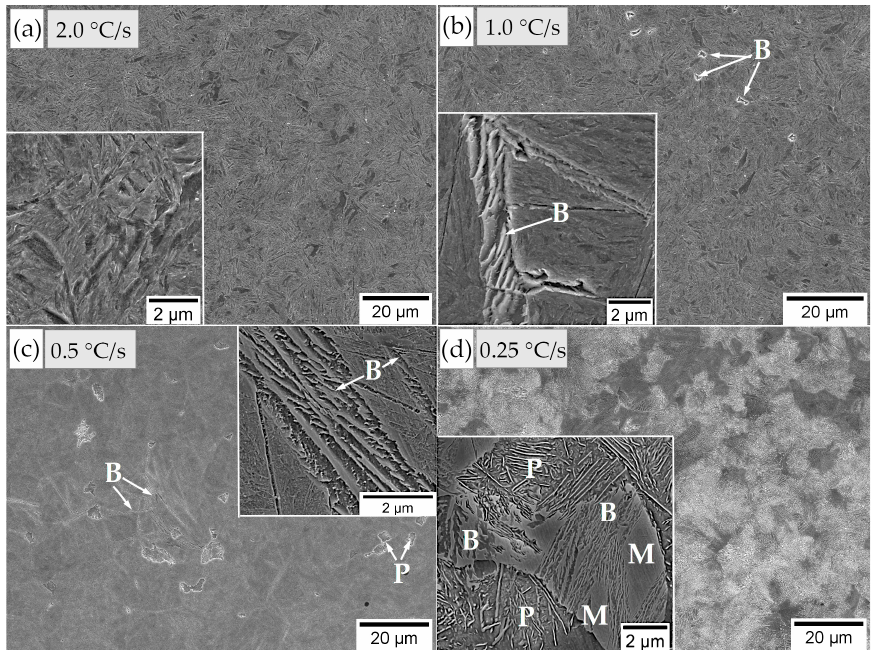
Figure 7. Microstructures of experimental steel after selected continuous cooling cycles. ( a ) 2.0 ◦ C/s; martensite. ( b ) 1.0 ◦ C/s; martensite and bainite. ( c ) 0.5 ◦ C/s; martensite, bainite, and locally visible pearlite. ( d ) 0.25 ◦ C/s; martensite, bainite, and pearlite. Scanning electron microscopy, etched by nital. B—bainite; P—pearlite;